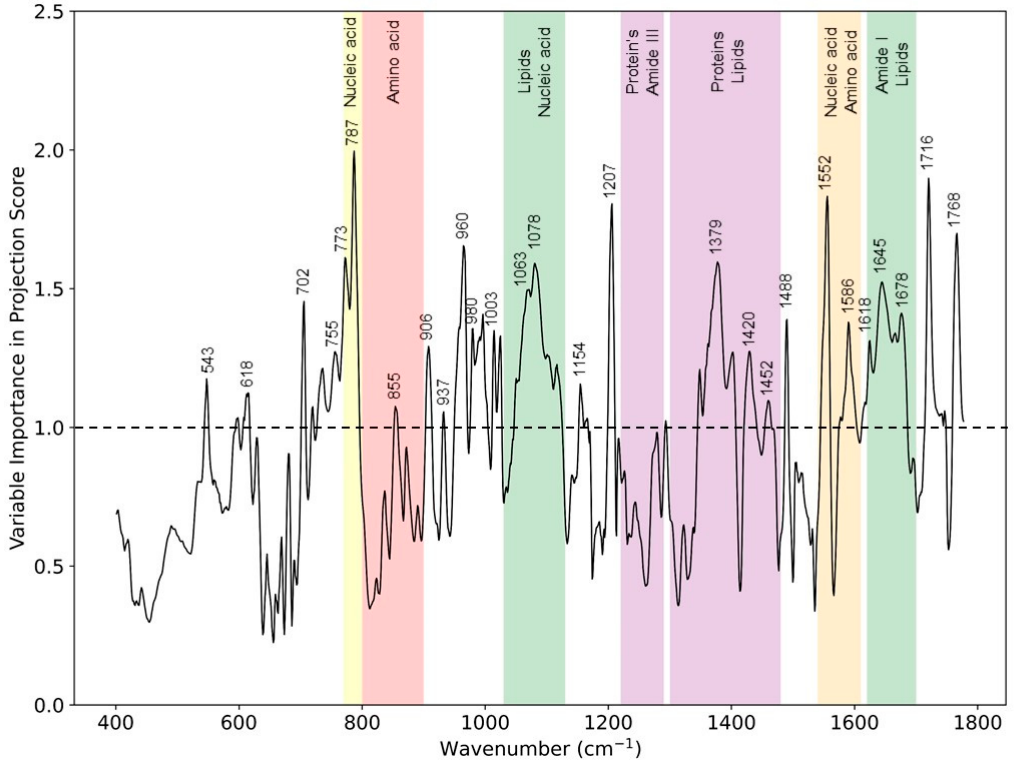
Figure 5. VIP scores from the PLS-DA classification model for eczema ( n = 52) and healthy subjects ( n = 20) depicting Raman peaks and wavebands having a numerical value greater than 1.